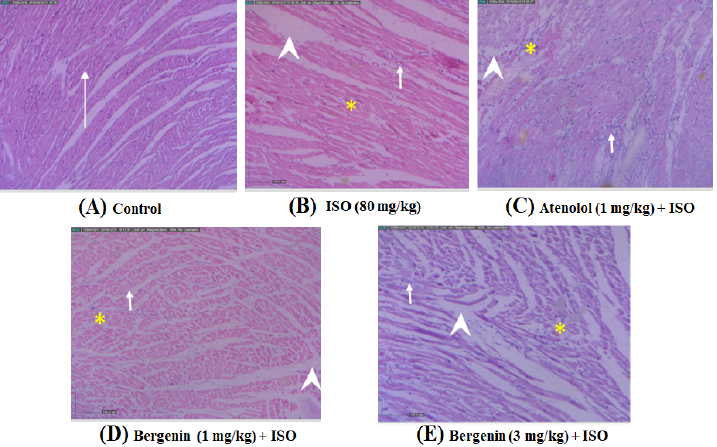
Figure 5. H and E (200×) staining of cardiac heart tissues of ( A ) control group, demonstrating normal cardiomyocytes (arrow). ( B ) Isoproterenol (ISO)-alone-administered indicates marked inflammation (arrow), edema (arrow head), and confluent necrosis (*, esteric). ( C ) Pretreatment with 1 mg/kg atenolol + ISO produced significant decrease in inflammation (arrow), edema (arrow head), and necrosis (*, esteric). ( D ) 1 mg/kg bergenin + ISO produced minimal decrease in the edema (head), inflammation (arrow), and necrosis (*, esteric); ( E ) 3 mg/kg bergenin + ISO produced maximal decrease in the inflammation (arrow), edema (arrow head), and necrosis (*, esteric), respectively.